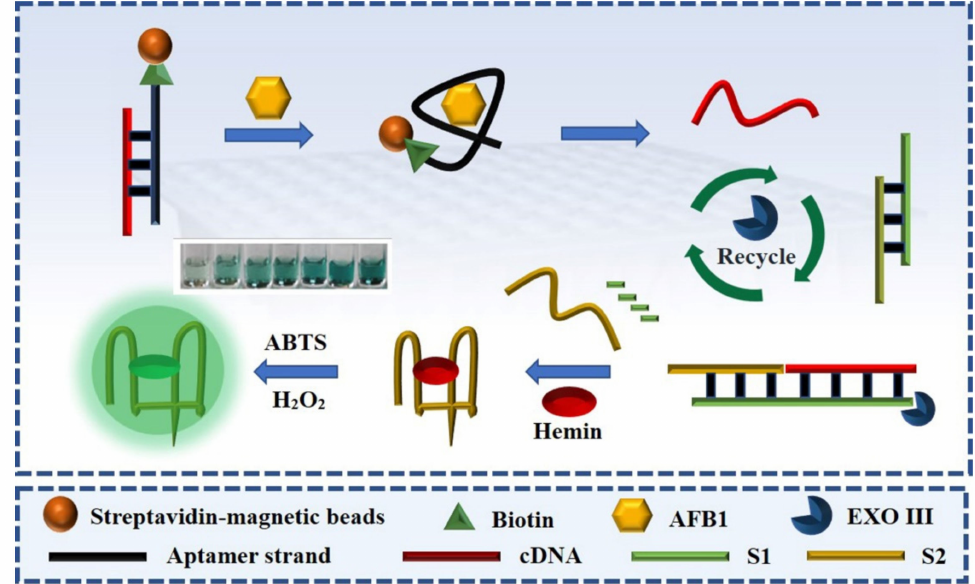
Figure 1. Schematic illustration of the Exo III-induced signal amplification aptasensor for the colorimetric detection of aflatoxin B1